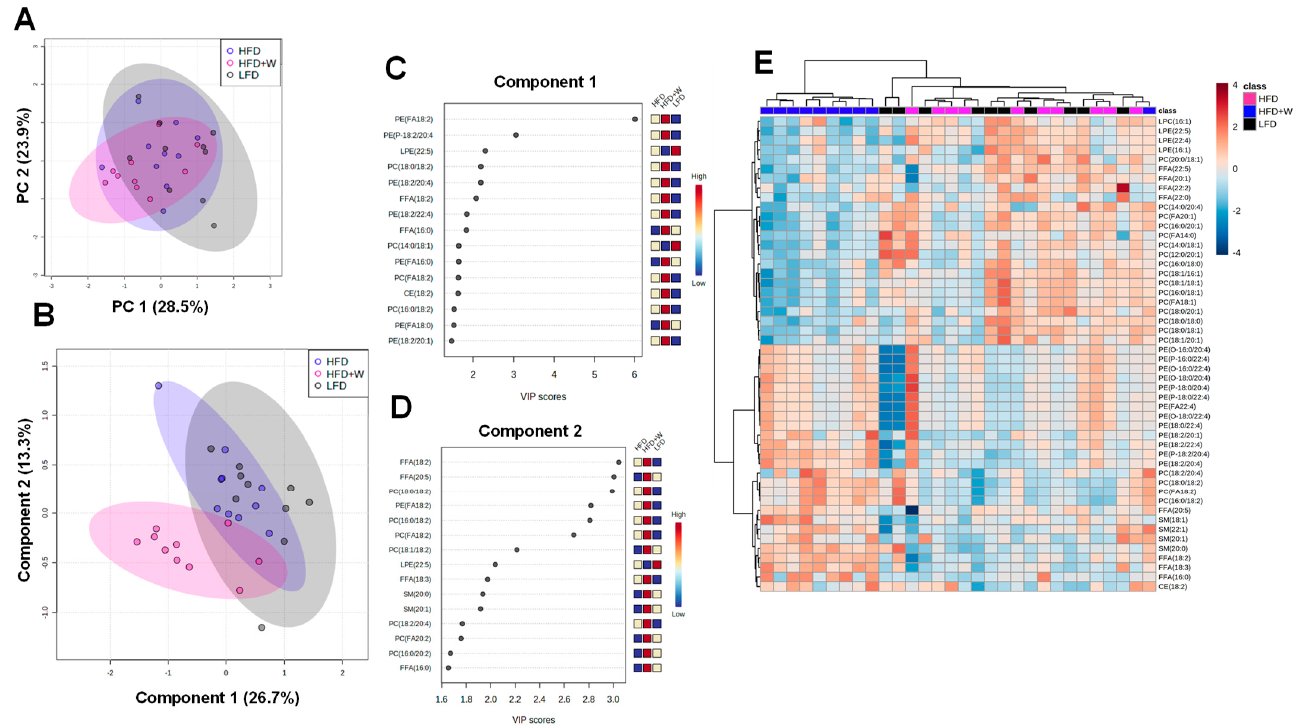
Figure 4. Effect of HFD and dietary walnuts on the hippocampal lipidome in aged male mice. ( A ) When comparing the lipidome among groups by unsupervised principal component analysis